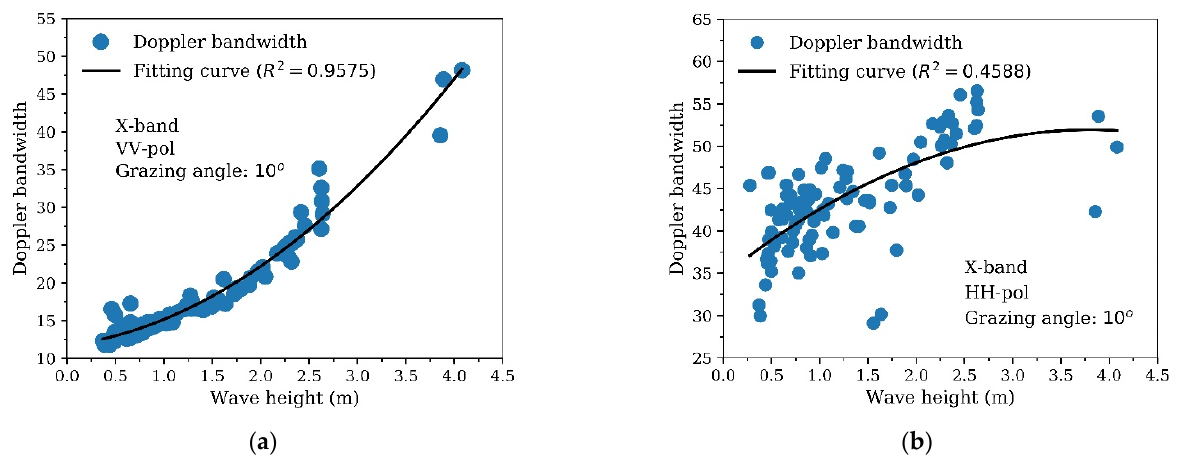
Figure 14. Characteristics of different polarization Doppler spectra in X-band at different wave heights in the Yellow Sea. ( a ) VV polarization; ( b ) HH polarization.